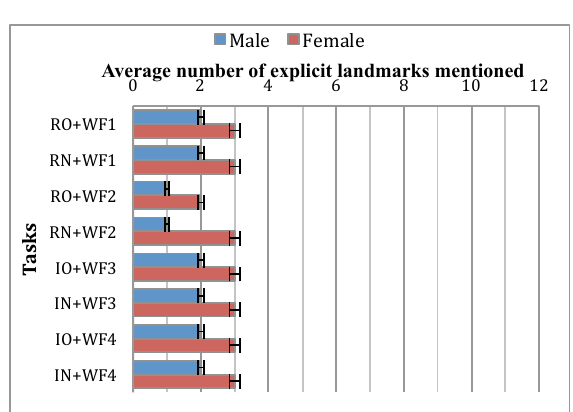
Figure 3. Average duration in seconds per route planning task